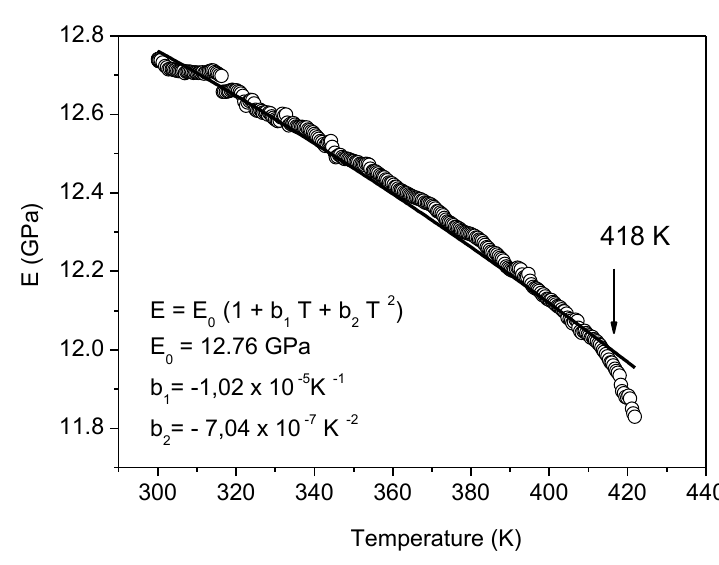
Figure 2. Q −1 and E trends of In from room temperature to 466 K.